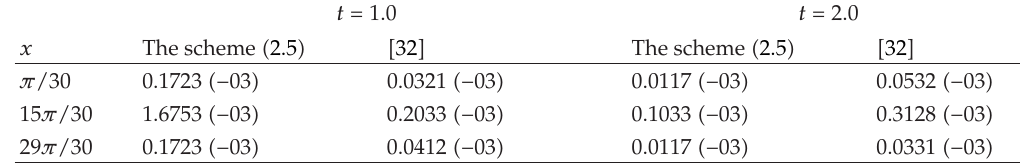
Table 6: Absolute errors of scheme (cid:3) 2.5 (cid:4) and the scheme in (cid:6) 32 (cid:7) (cid:3) h (cid:9) π/ 30 , τ (cid:9) 0 . 1 (cid:4) .